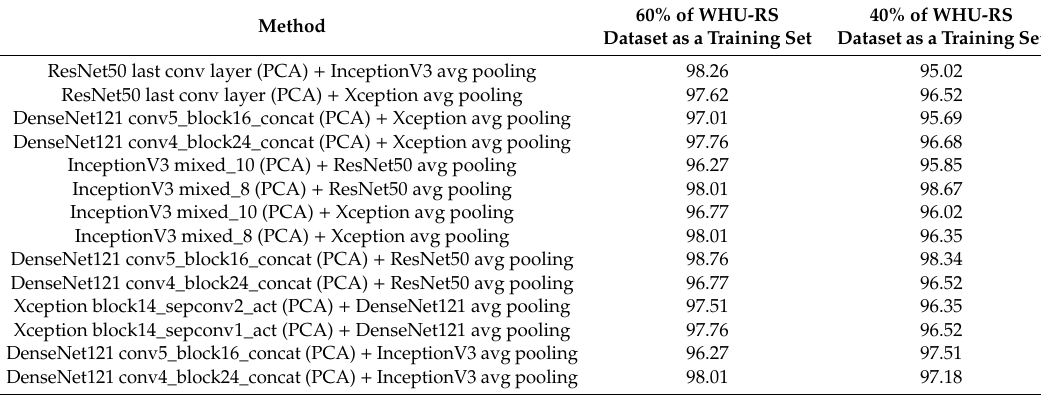
Table 6. The classification accuracy (OA (%)) of the linear classification of fused features with PCA transformation, with 60% and 40% of WHU-RS dataset as a training set.